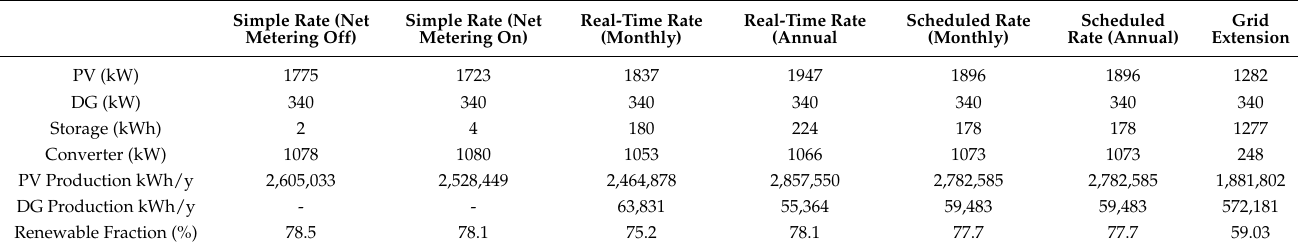
Table 8. Summary of simulation methods.